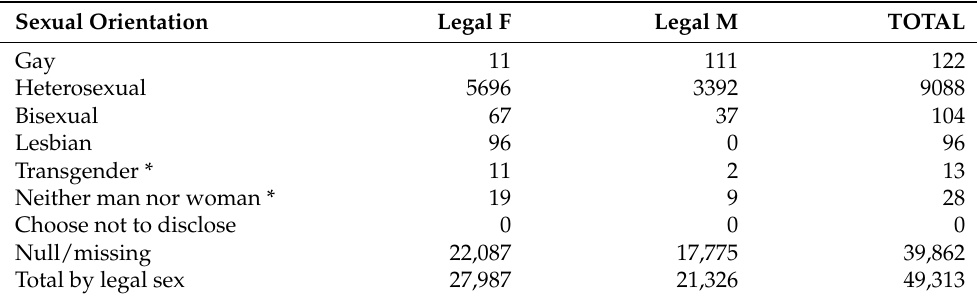
Table 3. Sexual orientation data for all Rush University Medical Center patients, 12 years and older, with unplanned hospital encounters in 2020 (N = 49,314). Sexual Orientation